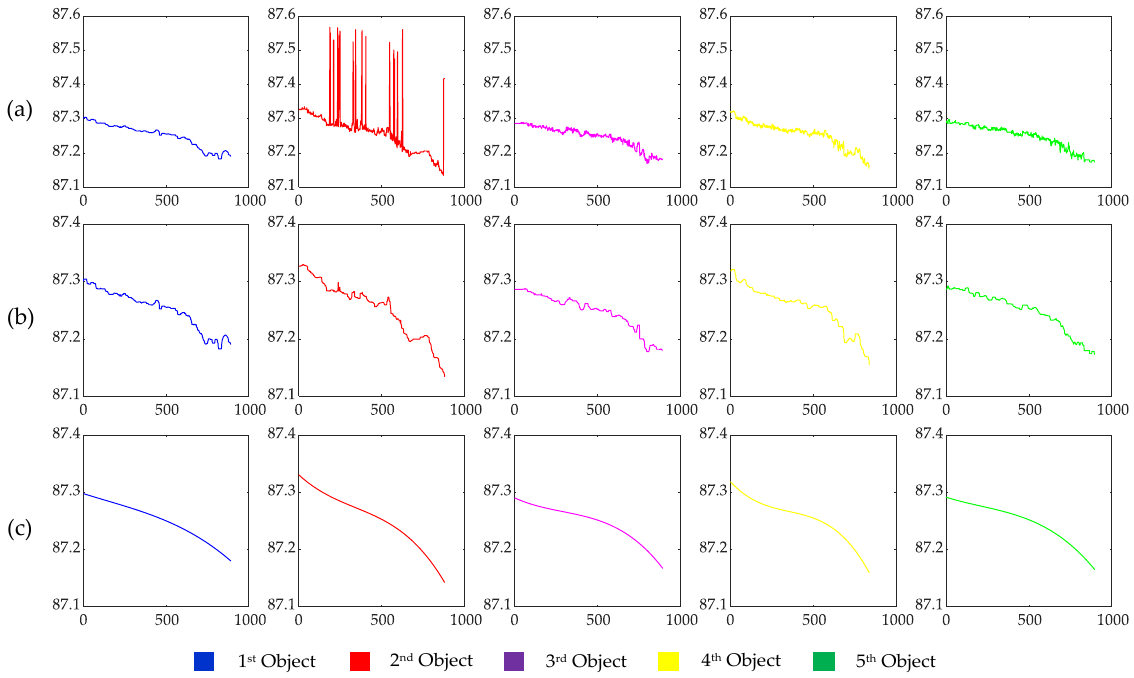
Figure 9. The elevation trajectories of moving objects in the world coordinate system. ( a ) The original trajectories in elevation; ( b ) the trajectories in elevation filtered by median filtering with the window size of 25; ( c ) the trajectories in elevation filtered by a cubic polynomial. The ordinate is Z (m), and the abscissa is the video frame number in ( a – c ).